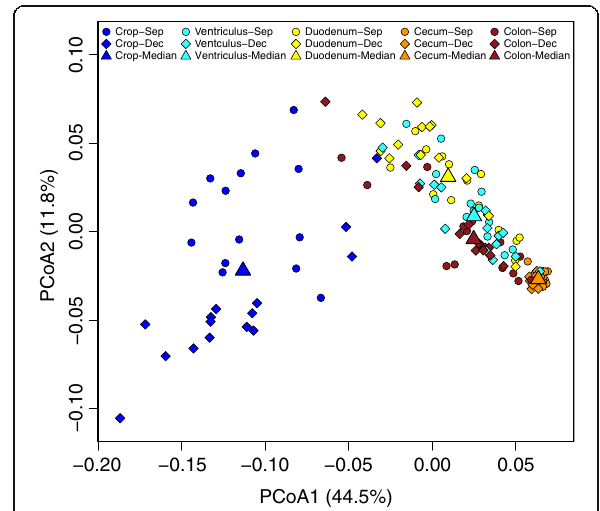
Fig. 2 Plot of the principal coordinate analysis of gut microbiota based on weighted UniFrac distances ( n =145 samples)